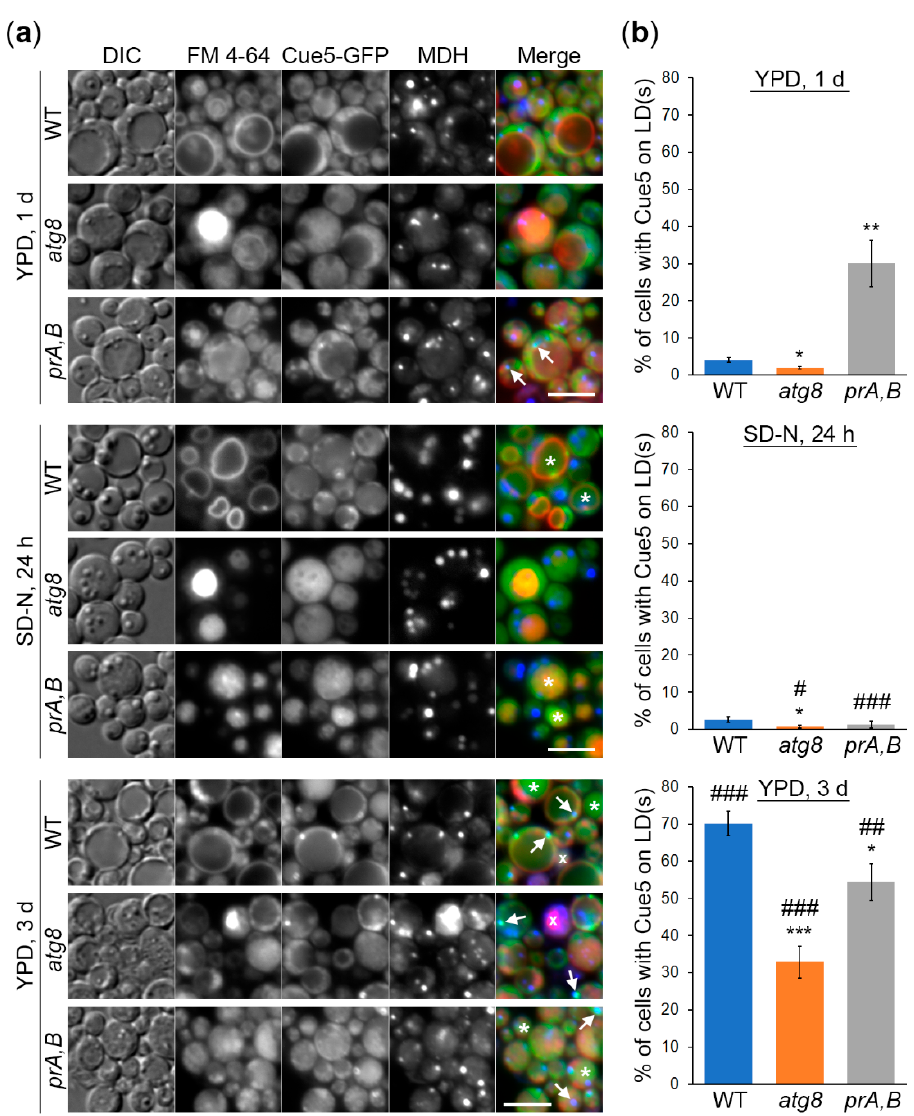
Figure 1. K. phaffii Cue5 accumulates on lipid droplets (LDs) specifically in the stationary (S) phase. The cells of wild-type (WT), atg8 and prA,B ( pep4 prb1 ) strains that express Cue5-GFP were grown for 1 d in YPD with the vacuolar membrane stain, FM 4-64 (red). During the last hour of growth, LDs were stained blue with monodansylpentane (MDH). One aliquot of cell cultures was imaged immediately after 1 d in YPD (top panels), while another was transferred to SD-N and imaged after 24 h (LDs were stained with MDH during the last hour) of nitrogen (N) starvation (middle panels). The rest of YPD cultures was incubated for 2 more days to reach the late S-phase (bottom panels). ( a ) Representative images. *: Vacuoles with Cue5-GFP; ↑ : LDs with Cue5-GFP; x: Dead cell. Scale bar, 5 µm. ( b ) Quantification of images in ( a ). Displayed are the averages and standard errors. * and #: p ≤ 0.05; ** and ##: p ≤ 0.01; *** and ###: p ≤ 0.001; *, ** and ***: mutant versus WT at the same time-point; #, ## and ###: “SD-N, 24 h” or “YPD, 3 d” versus “YPD, 1 d” for the same strain.